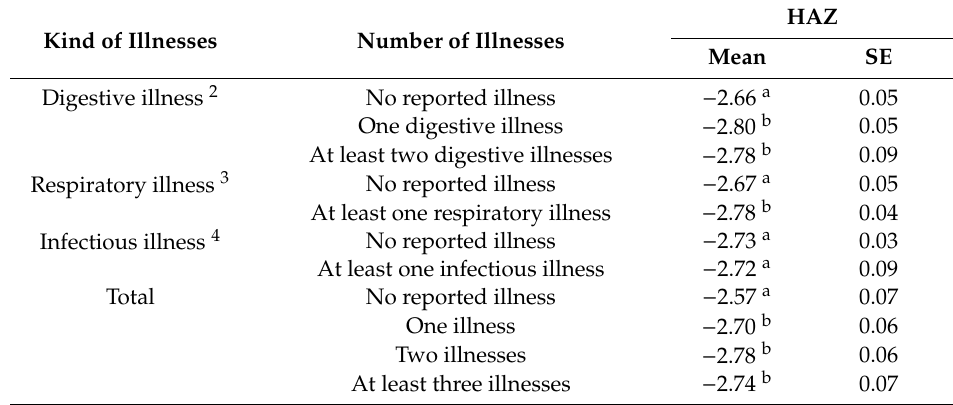
Table 4. HAZ among stunted children in relation with kind and frequency of reported illnesses in the previous month 1